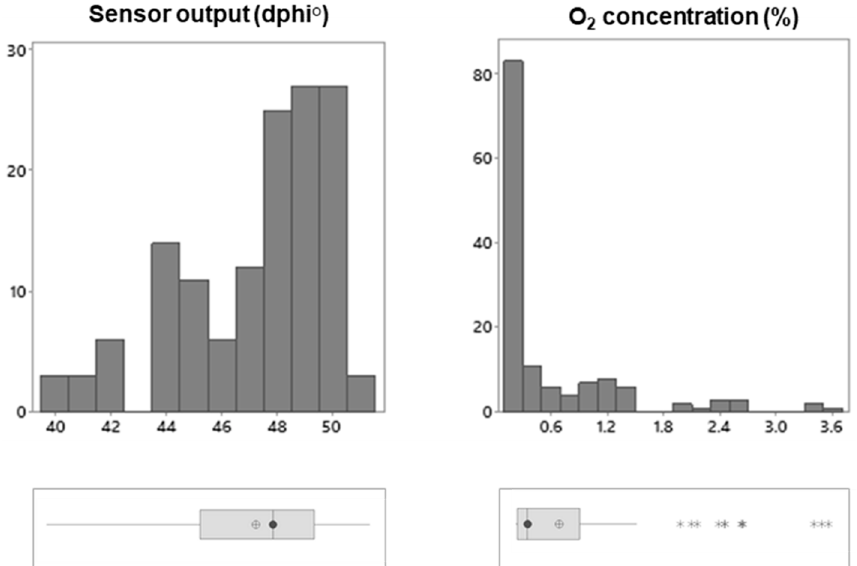
Figure 3. Initial screening of the VP meat samples for the residual O 2 levels on the day of packaging. Histograms of the data (n = 137) show the distribution of the measured dphi ◦ signals and the calculated O 2 concentrations (%). The box plots show the interquartile data range, the vertical line and λ in the boxes represent the median values and ⊕ represents the mean. The whiskers represent the ranges for the bottom 25% and the top 25% of the data values, excluding the outliers ( ).